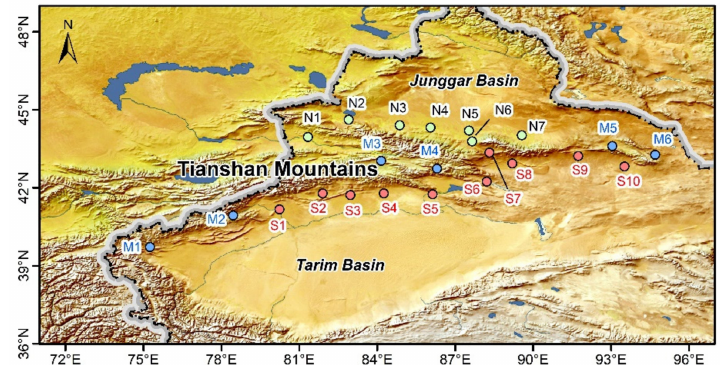
Figure 1. Spatial distribution of the sampling sites around the Tianshan Mountains. Northern slope: N1-Yining, N2-Jinghe, N3-Kuytun, N4-Shihezi, N5-Caijiahu, N6-Urumqi, and N7-Qitai; Mountains: M1-Wuqia, M2-Akqi, M3-Bayanbulak, M4-Balguntay, M5-Barkol, and M6-Yiwu; Southern slope: S1-Aksu, S2-Baicheng, S3-Kuqa, S4-Luntai, S5-Korla, S6-Kumux, S7-Dabancheng, S8-Turpan, S9-Shisanjianfang, and